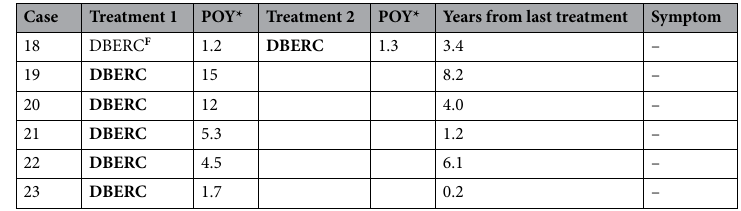
Table 4. Treatment history of six patients with anastomotic strictures. Superscripted plus sign ( + ) beside the case number: bile duct plasty was performed at the time of the primary operation. DBERC : Complete lithotripsy. DBERC F : Residual stones after DBERC. *POY: postoperative years. DBERC, double-balloon endoscopic retrograde